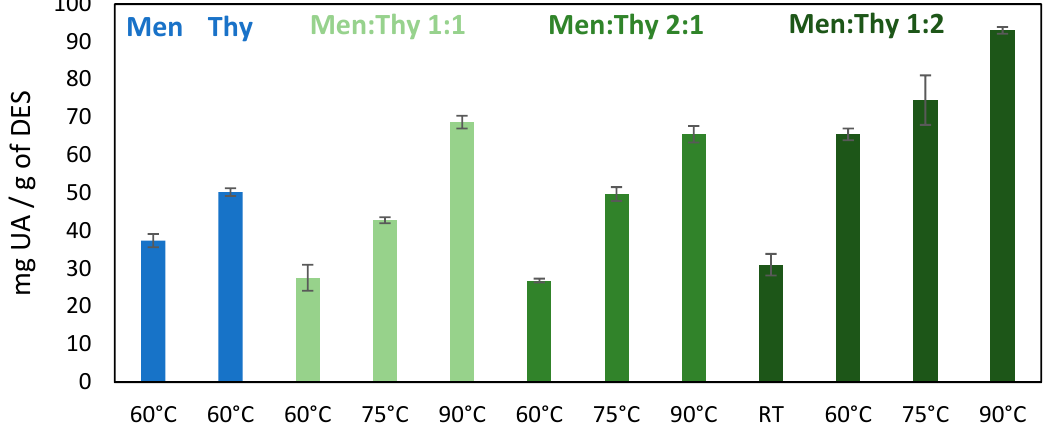
Figure 4. Solubility of ursolic acid (UA) in menthol and thymol at 60 °C and in menthol:thymol natural deep eutectic solvents (NADES) in different proportions (1:1, 1:2, 2:1) at different temperatures (RT, 60, 75, 90 °C).